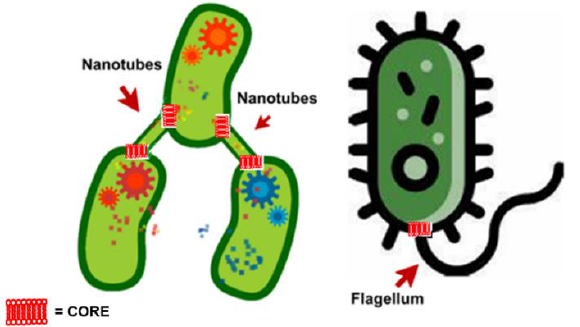
Figure 5. Conserved flagellar CORE components dually serve for flagella and nanotube assembly.